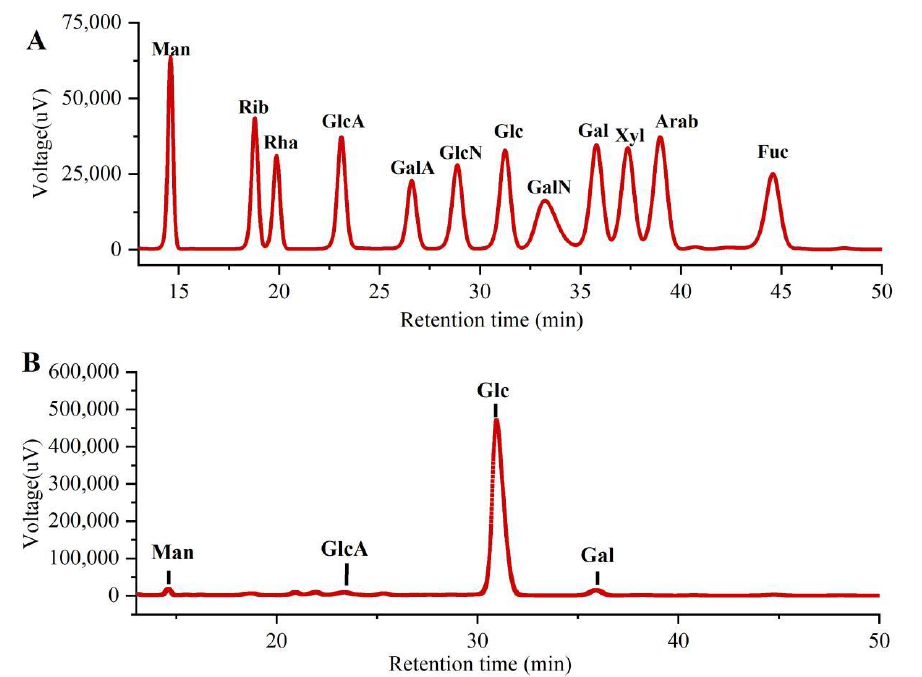
Figure 3. Monosaccharide compositions of PLE by HPLC analysis. ( A ) Standard samples and ( B ) PLE. PLE: Polysaccharides of L. edodes . Fuc: fucose; Gal: galactose; GalA: galacturonic acid; GalN: galactosamine; Glc: glucose; GlcA: glucuronic acid; GlcN: glucosamine; Man: mannose; NMR: nuclear magnetic resonance; Rib: ribose; Rha: rhamnose; Xyl: